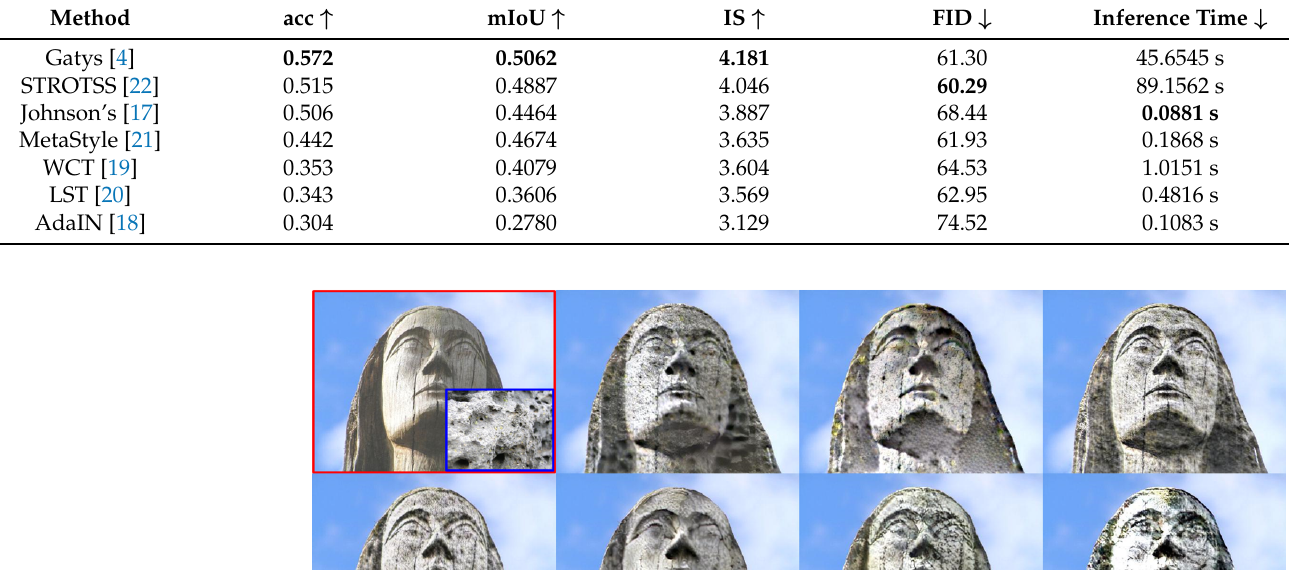
Table 3. Quantitative results of all evaluated NST methods. Inference time is measured on a single GTX 1080 Ti GPU.